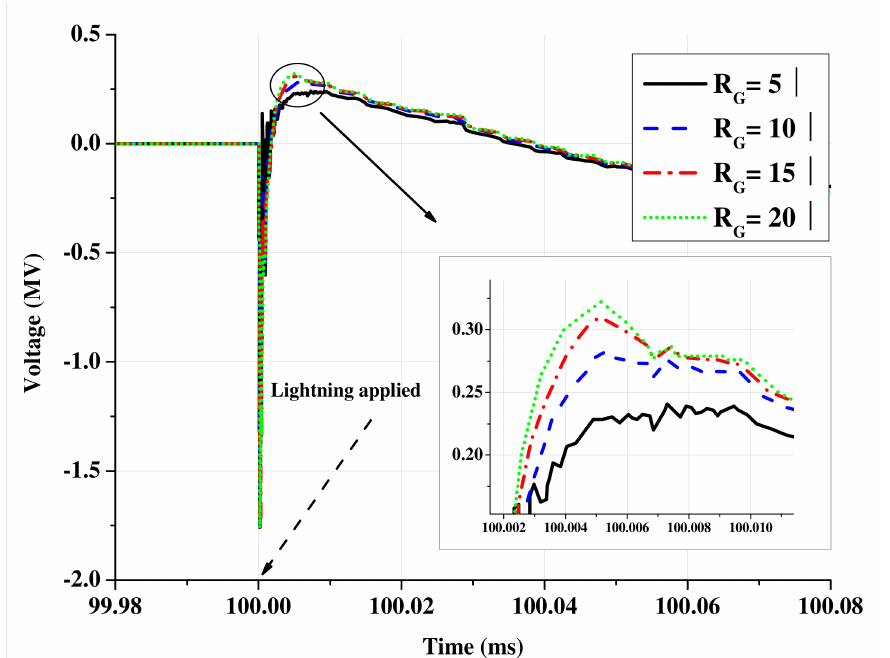
Figure 17. Voltage at DC tower cross-arm with changing tower grounding resistance.